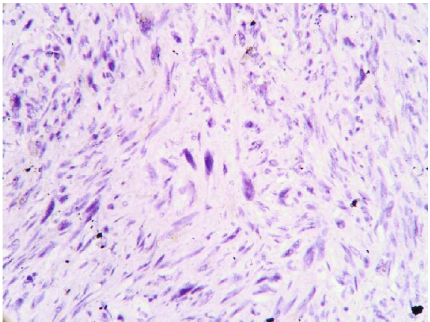
Figure 9: Poorly di ff erentiated malignant mesenchymal tumor. Immunohistochemistry assay with CD117 antibodies. Negative reaction in tumor cells observed.